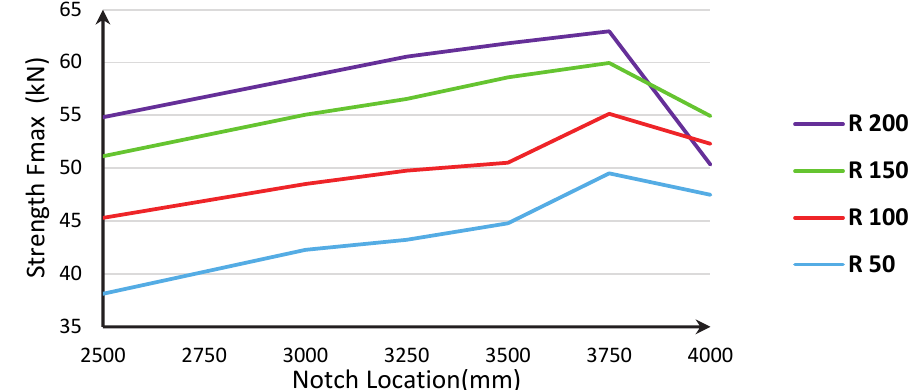
Figure 21: The effect of notch length and its location on the TCC beam